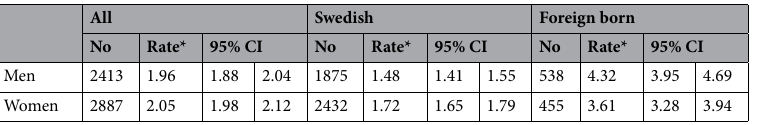
Table 2. Incidence rate (per 100, 000 person years) of post-polio in the first-generation individuals, 1998– 2018. *Adjusted for World standardized population.